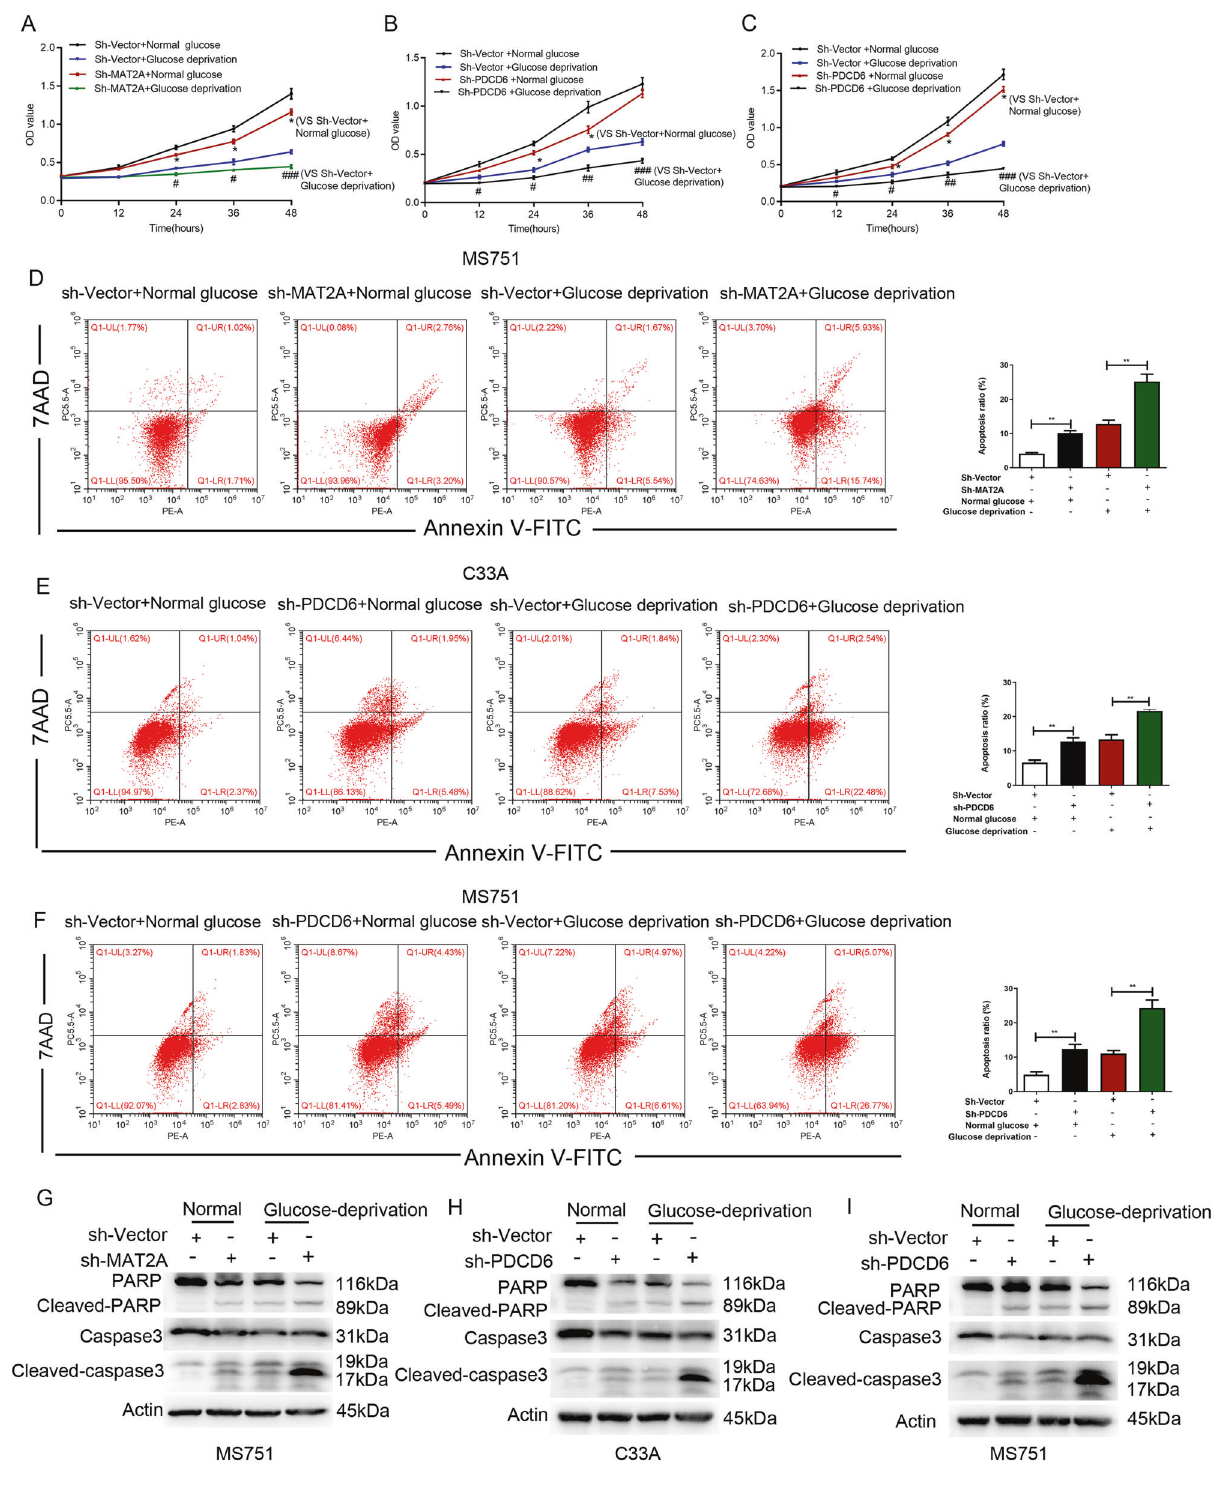
MAT2A and PDCD6 are highly expressed and correlated with poor prognosis in cervical cancer To examine the clinical relevance of the relationship between MAT2A and PDCD6, 67 pairs of cervical cancer tissues and matched normal cervical tissue specimens were collected for IHC analyses. Results showed that both MAT2A (Fig. 5A) and PDCD6 (Fig. 5B) displayed an upregulated expression in tumor tissues Cell Death Discovery (2022)